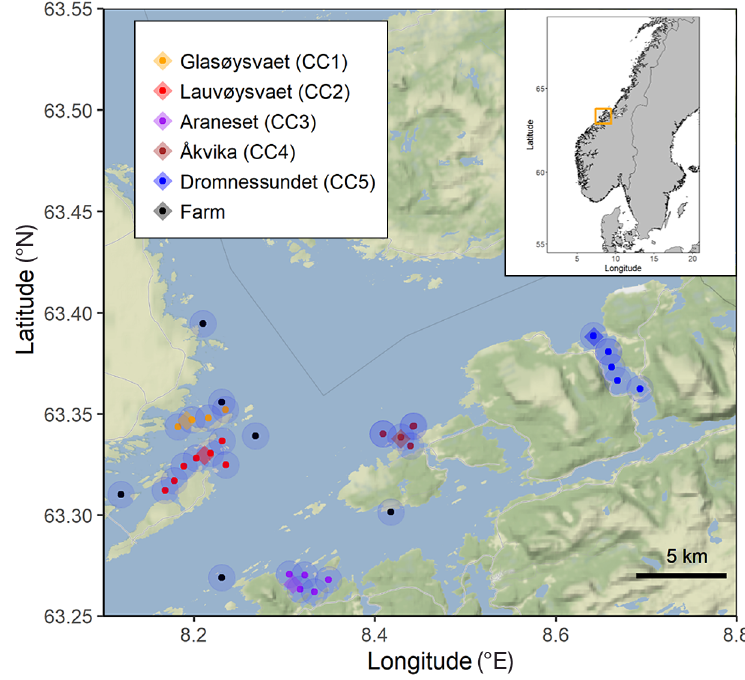
Fig. 1. Positions of the 30 stations providing data for the present study. Farm represents the location of salmon farms where a receiver was deployed. Insert in the top right corner shows the study area location, boxed, on the Norwegian coast. Transparent circles: approximate detection range of the receivers as cal- culated from range testing (i.e. outer circle edge represent approximate dis- tance where 50% of tag transmissions are expected to be detected; see Text S1, Tables S3−S4, Figs. S2−S7 in the Supplement for further details). Diamonds: average re lease positions of fish post-tagging in each catch cluster; different stations are coloured according to the spawning ground they are